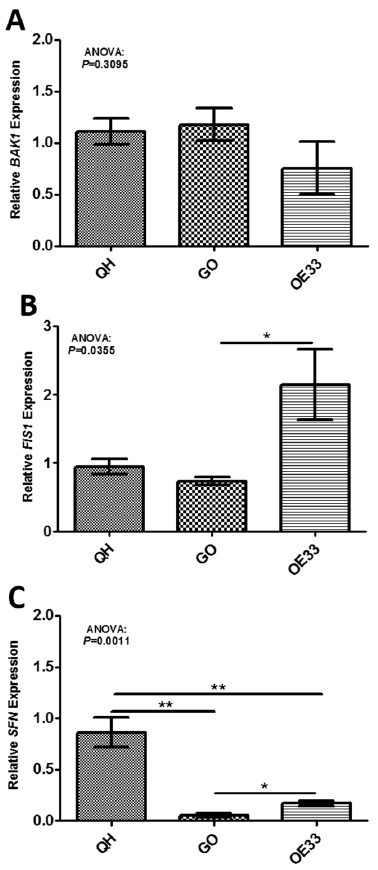
Figure 1. In vitro validation of global mitochondrial function gene targets found to be differentially expressed across the Barrett’s cell lines. ( A ) BAK1 ( p > 0.05), ( B ) FIS1 ( p < 0.05) and ( C ) SFN ( p < 0.05) were differentially expressed between the in vitro Barrett’s cell lines (unpaired t -test; Bonferroni post-hoc test). One-way ANOVA was used to investigate differences across the in vitro Barrett’s sequence for BAK1 ( p = 0.3095), FIS1 ( p = 0.0355) and SFN ( p = 0.0011). Bars denote mean ± SEM ( n = 3). * p < 0.05 and ** p < 0.01.